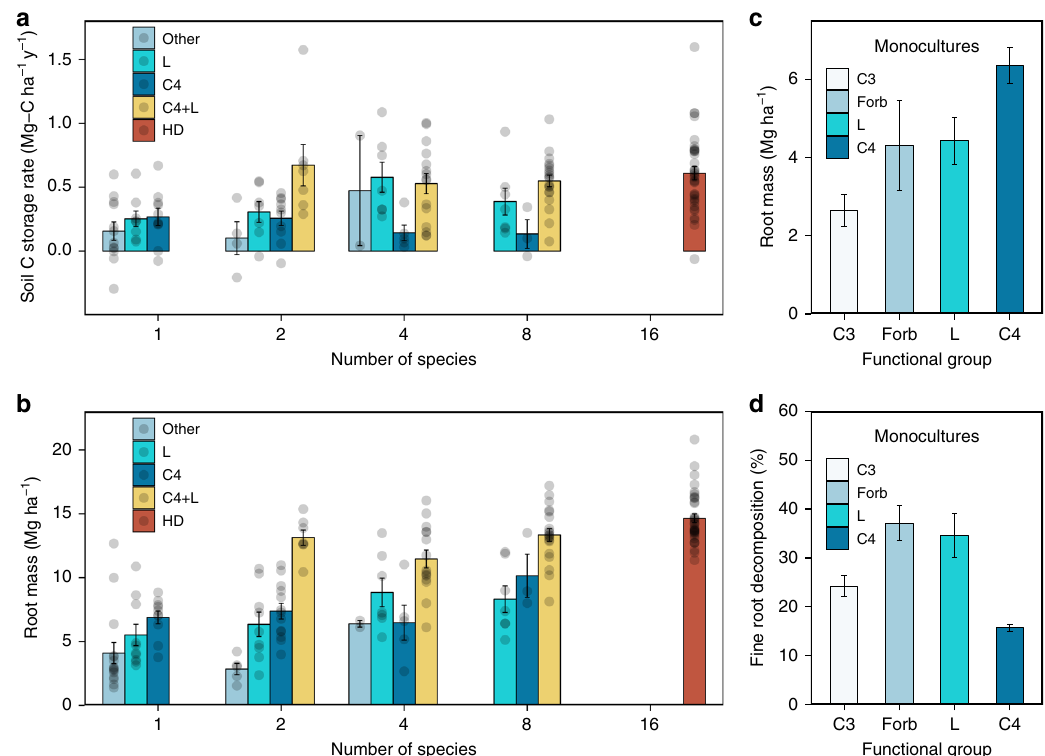
Fig. 4 Functional composition and traits in fl uence root biomass and soil C storage. a Soil C storage rates over the entire 22 years for the 0 – 60 cm pro fi le. b Mean root biomass for the 0 – 60 cm soil pro fi le (average of 2006, 2015, and 2017). c Mean root biomass of different functional groups in monoculture plots (0 – 30 cm soil pro fi le, average of 2006, 2015, and 2017). d Fine root decomposition percentage of different functional groups (measured after 10 months of fi eld incubation, which included ~5 winter months 54 ). In all panels, bars are means with standard errors. In a and b , dots indicate plot results: C4 — plots with at least one C4 but without legume; L — plots with at least one legume but without C4; C4 + L — plots with at least one C4 and one legume; Other — forbs, C3, or woody; HD — 16-species plots, which include both C4 and legume (of typically 3 – 4 species each). In c and d for monoculture plots,